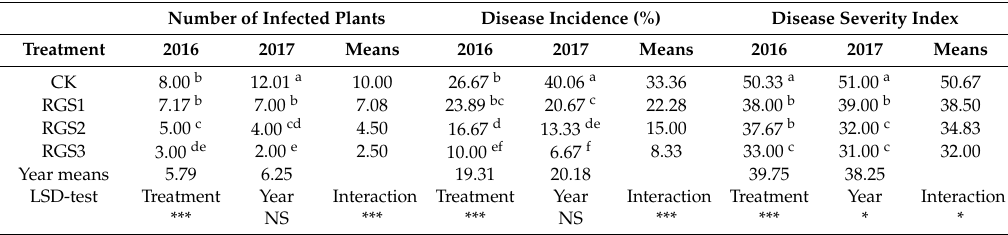
Table 5. Effect of different ratios of raw garlic stalk on Fusarium wilt incidence of eggplant during 2016 and 2017. Treatment Number of Infected Plants Disease Incidence (%) Disease Severity Index